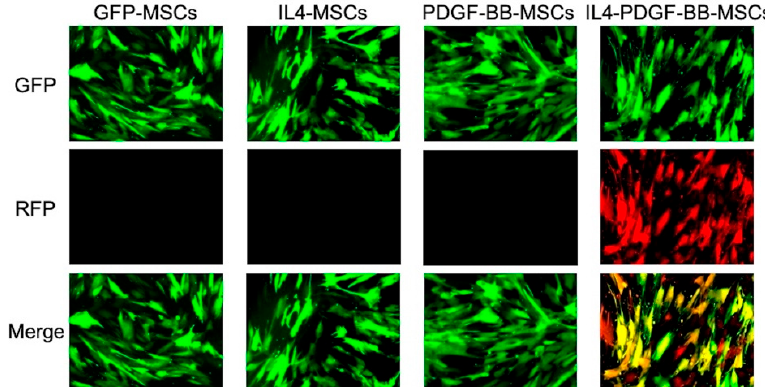
Figure 1. Representative fluorescence microscopy images of mesenchymal stromal cells (MSCs) infected by IL-4 and/or PDGF-BB lentiviral vectors. GFP-MSCs, MSCs infected with control GFP-positive lentivirus vector; IL4-MSCs, MSCs infected with rIL-4 secreting GFP-positive lentivirus vector; PDGF-BB-MSCs, MSCs infected with hPDGF-BB secreting GFP-positive lentivirus vector; IL4-PDGF-BB-MSCs, previously established IL4-MSCs infected with hPDGF-BB secreting RFP-positive lentivirus vector.